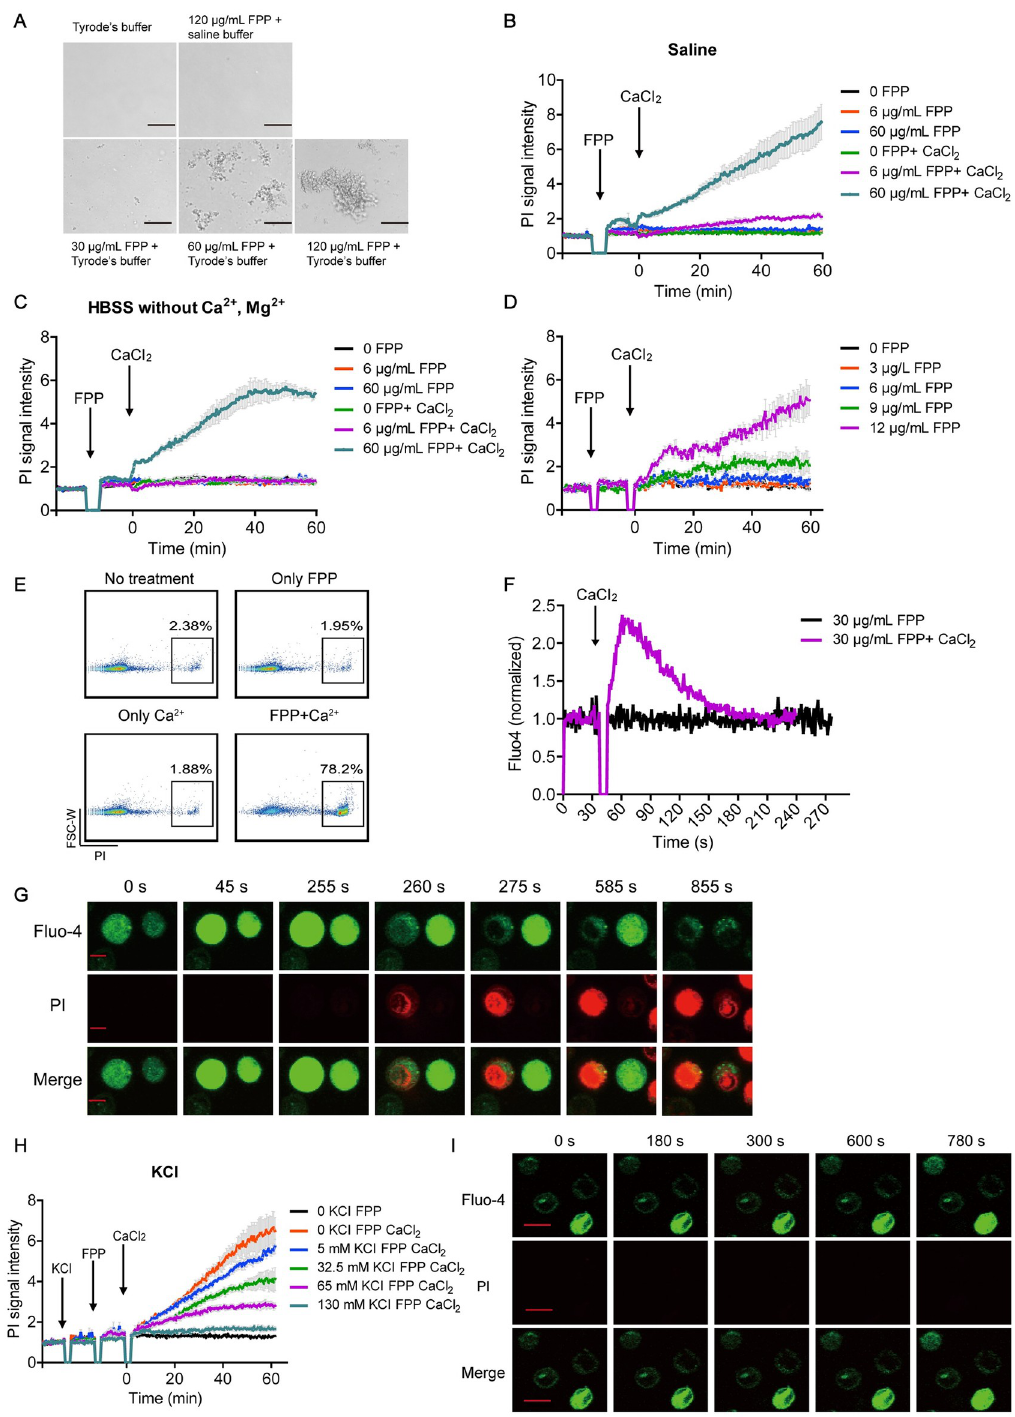
Fig 4. Extracellular calcium influx is vital for FPP-induced cell death. (A) Precipitates observed when different concentrations of FPP in H 2 O were added to Tyrode’s buffer or saline buffer. The scale bar indicates 100 μ m. (B, C) Cells in saline buffer (B) or HBSS without calcium and magnesium (C) were treated with FPP, and PI signal changes in the presence or absence of calcium were measured under fluorescent microplate reader. Black arrows indicate the time points at which FPP is added. Bars denote mean ± SEM (SEM in gray). Significant difference between 60 μ g/mL FPP with CaCl 2 and the no CaCl 2 control in saline buffer shows up after 15 minutes ( p < 0.05). Significant difference between 60 μ g/mL FPP with CaCl 2 and